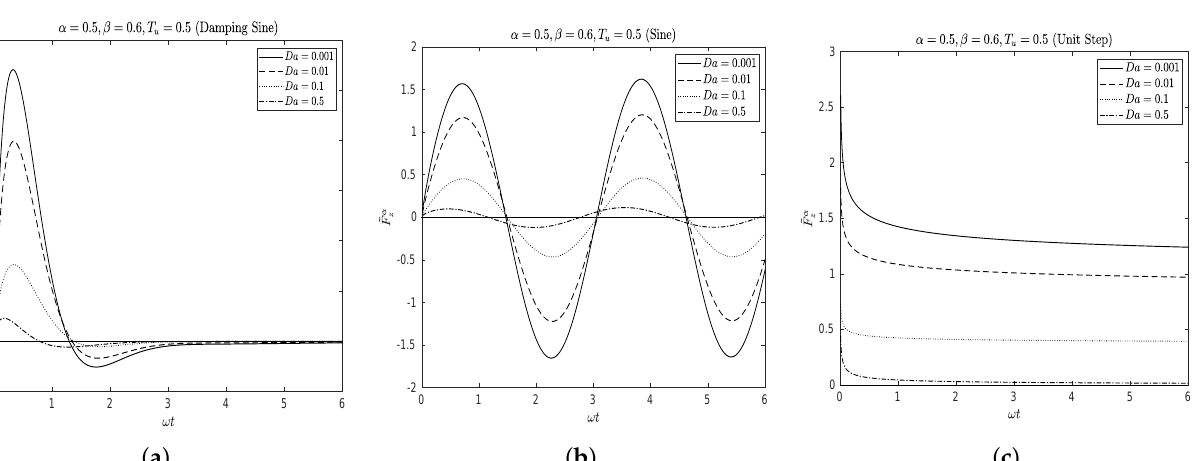
Figure 6a–c present variation of drag force versus the time parameter for different values of Darcy number ( Da ) at fixed α = 0.5, β = 0.6 and T u = 0.5. It can readily be seen that an increase in Darcy number ( Da ) reduces the drag force. This occurs due to the fact that increase in Darcy number increases the permeability of the porous medium which helps ease the fluid flow inside the porous particle and this leads to a decrease in the drag force. It is to be noted that the force reflects the pattern of the basic flow, for example if the basic flow is damping sine, the force exhibits damping behavior and eventually becomes zero at larger time. If the basic flow is oscillatory, the force exhibits oscillatory behavior. In case of the basic flow taken as unit step function, the force obtained is large in magnitude at ω t = 0 and the magnitude decreases as ω t grows. It can be concluded that the use of fractional order derivatives exhibits the history (‘memory’) of the basic flow in the obtained physical quantities of interest.